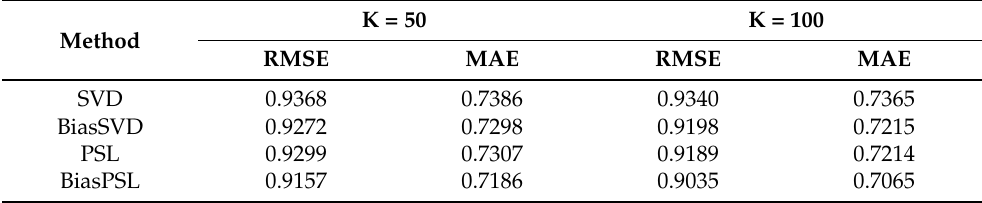
Figure 7. Training process of compared models on MovieLen-10 M with 100 latent factors. The performance of the four models on the datasets is shown below in Tables 2–4. Table 2. The prediction result on MovieLen-100